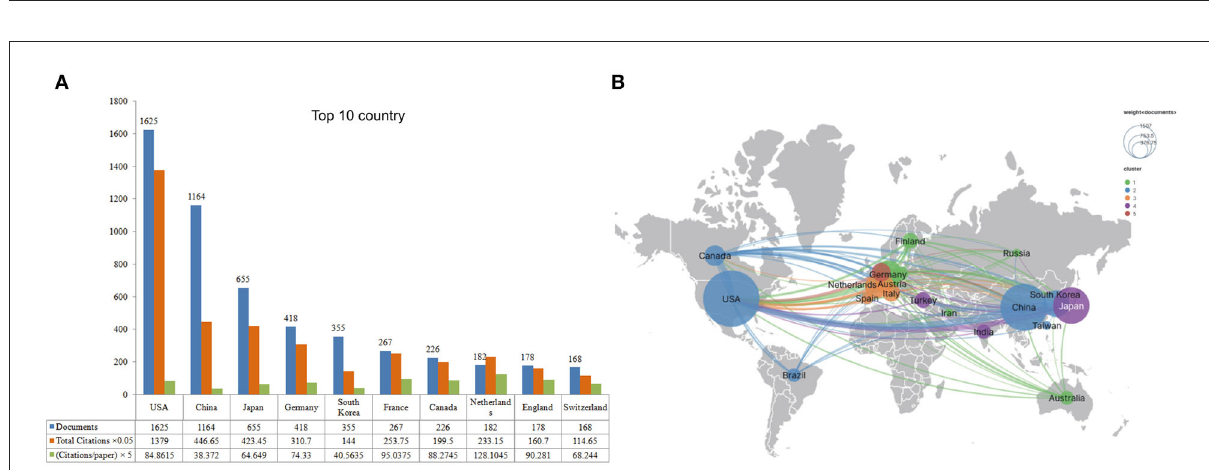
FIGURE3 The top 10 prolific countries/regions and inter-national collaboration network of IA research from 2012 to 2021. (A) The number of publications, citations ( × 0.05), and citations per paper ( × 5). (B) The collaborative map of countries for IA. Node size indicates the number of articles produced. The width of links indicates the cooperation